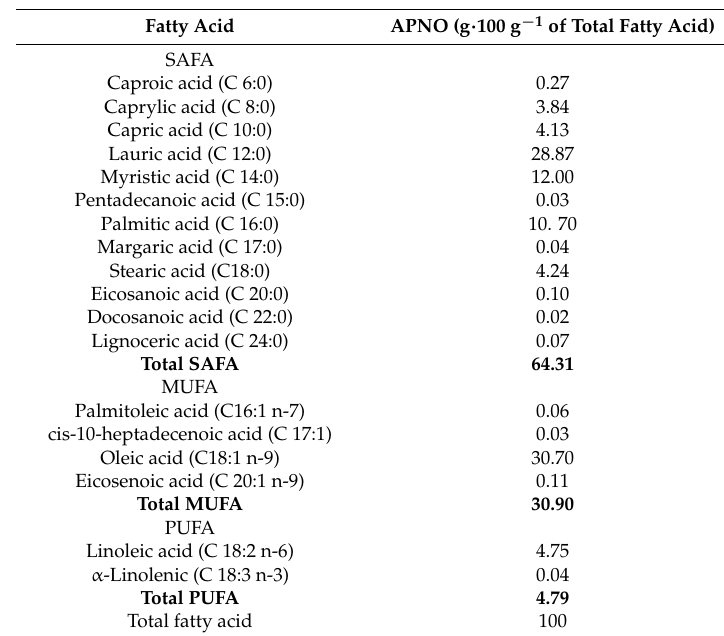
Table 1. Fatty acid composition of A. phalerata nut oil